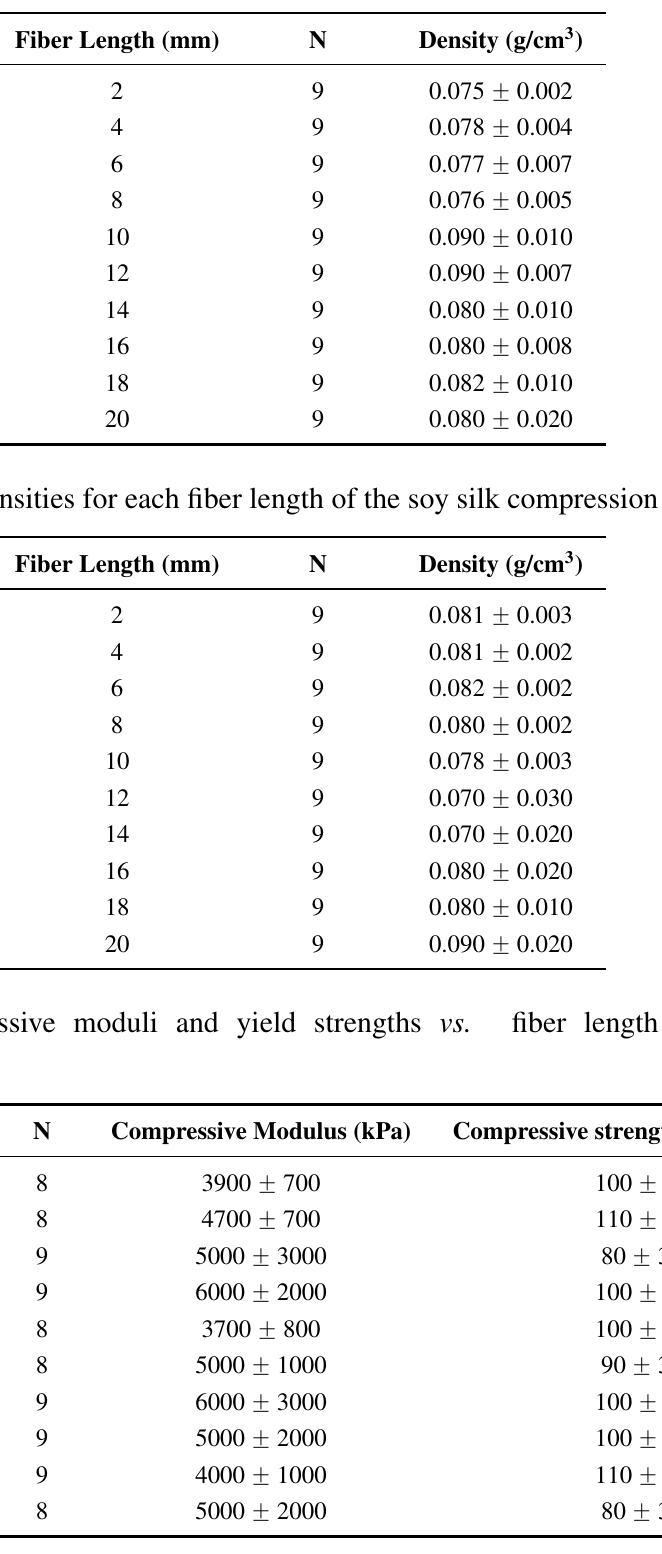
Table 2. Average densities for each fiber length of the silk compression series samples.